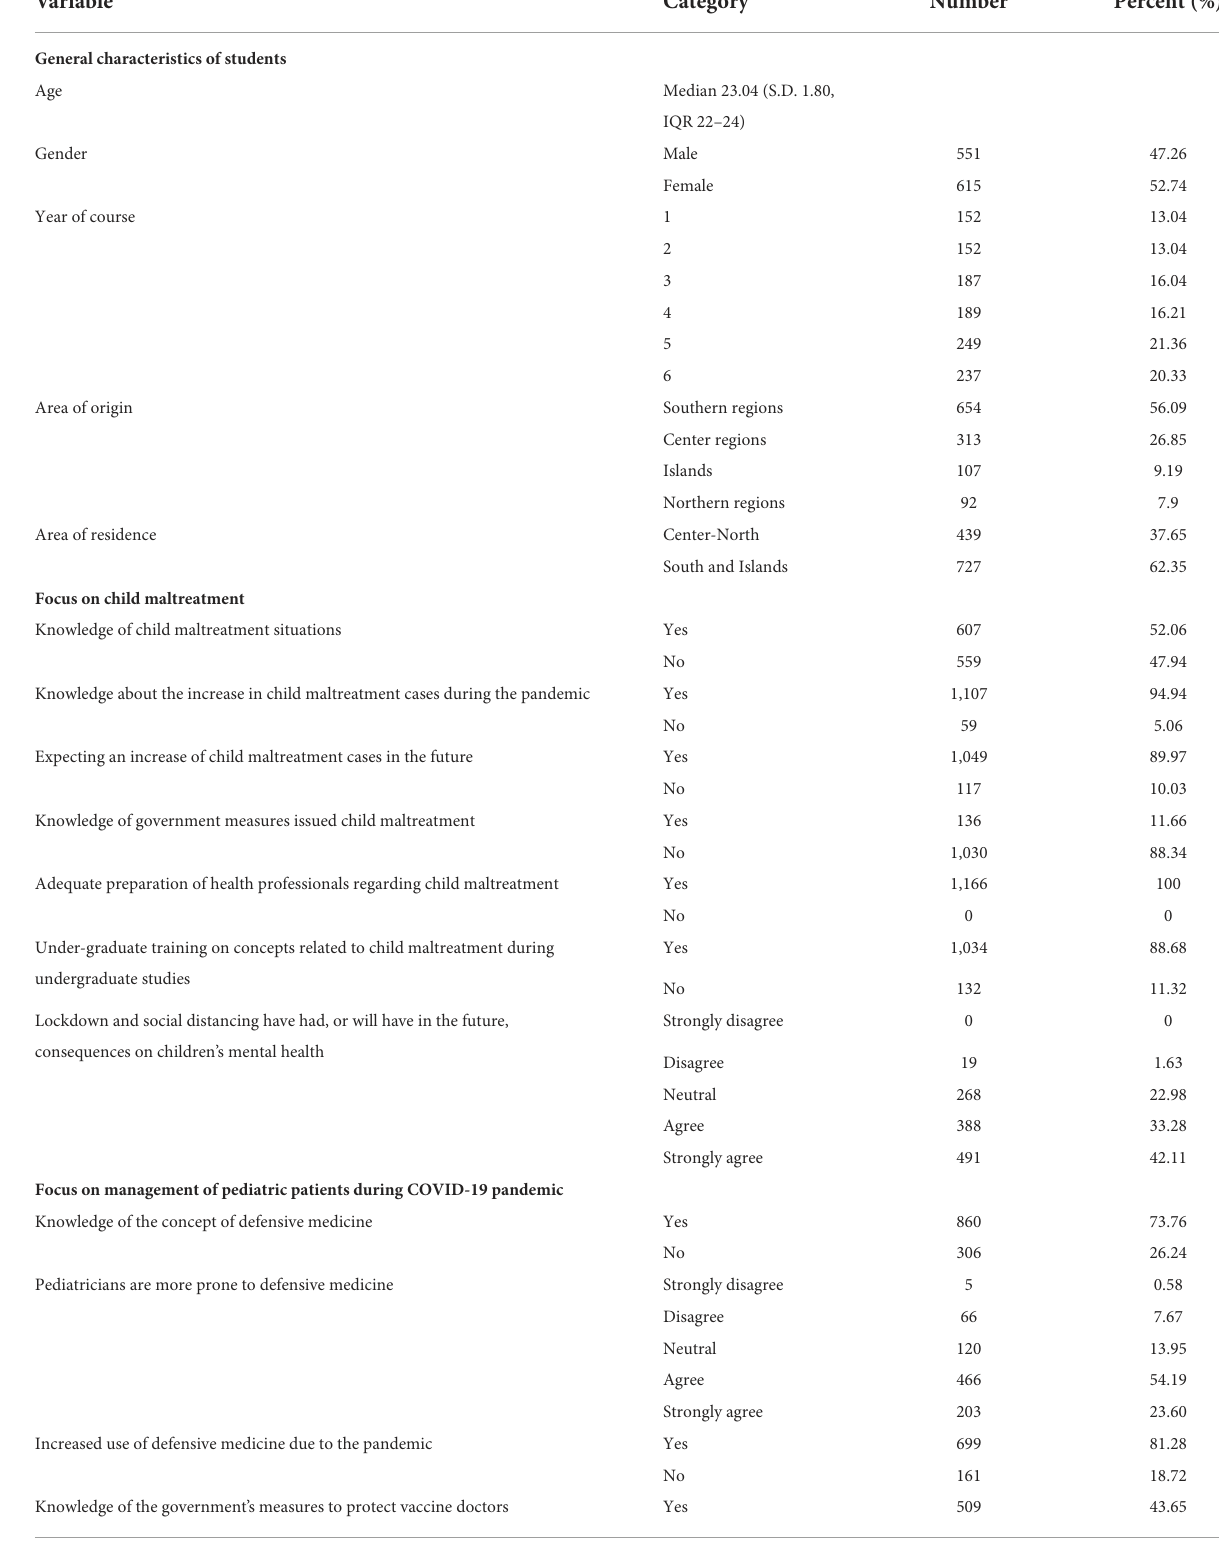
TABLE 2 Student responses to the questionnaire